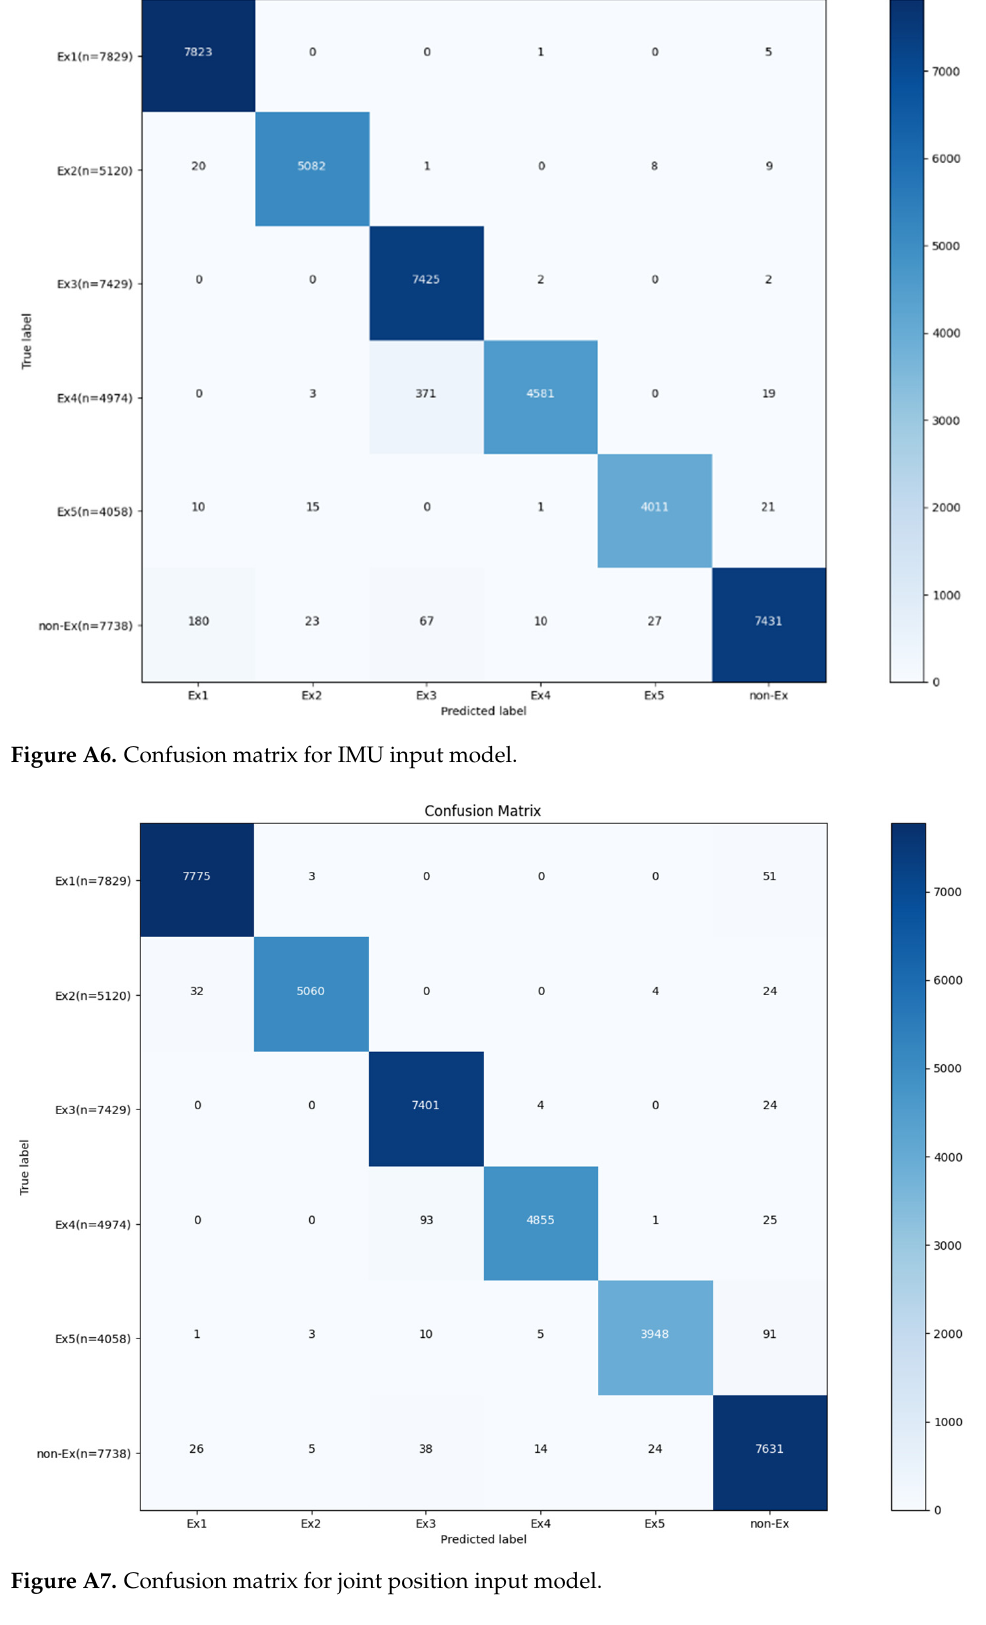
Figure A7. Confusion matrix for joint position input model.